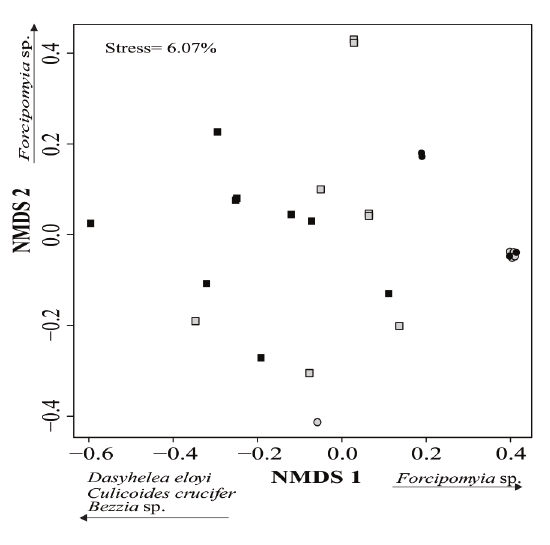
Figure 2 - Non-Metric Multidimensional Scaling (NMDS) and taxa of Ceratopogonidae selected by Similarity percentage tests (SIMPER) to explain the dissimilarity between open and closed areas in terms of Ceratopogonidae abundances in artificial containers located in an urban forest fragment in Central Amazon. Gray square = open area in rainy season; Black square = open area in dry season; Gray circle = closed area in rainy season; Black circle = closed area in dry season.